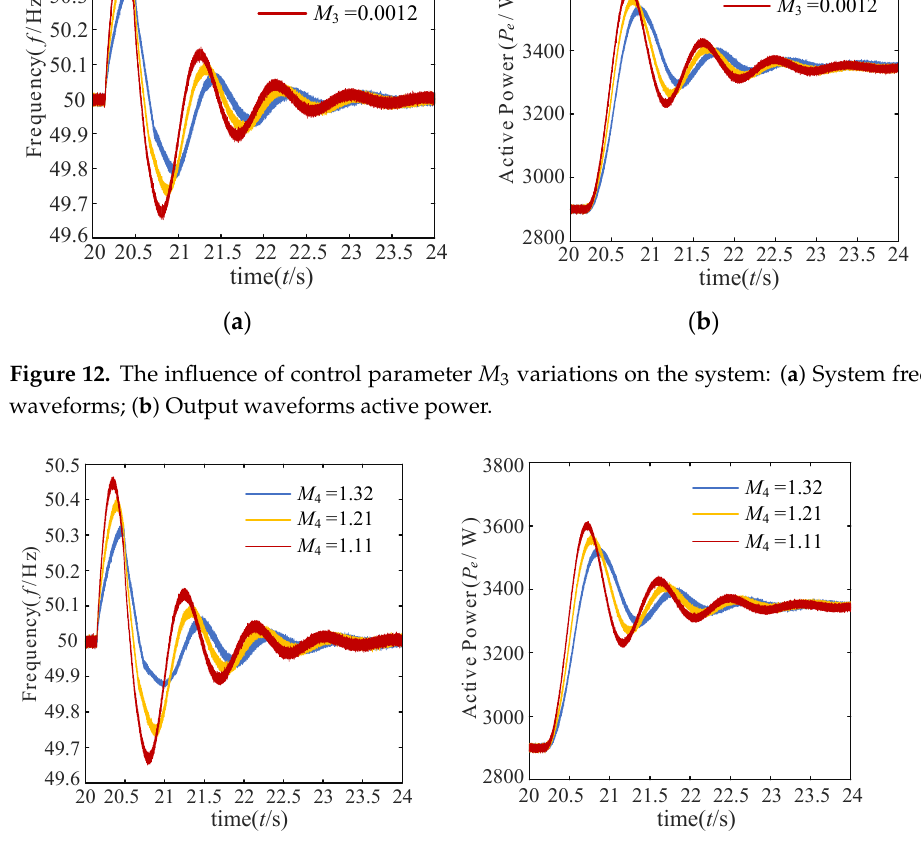
Figure 12. The influence of control parameter M 3 variations on the system: ( a ) System frequency waveforms; ( b ) Output waveforms active power.